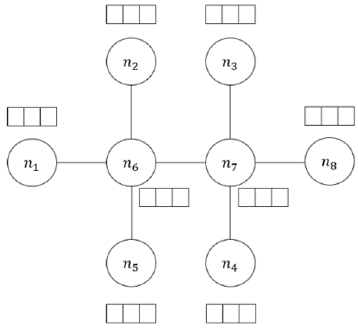
Figure 2. Graph Convolution Network (GCN).